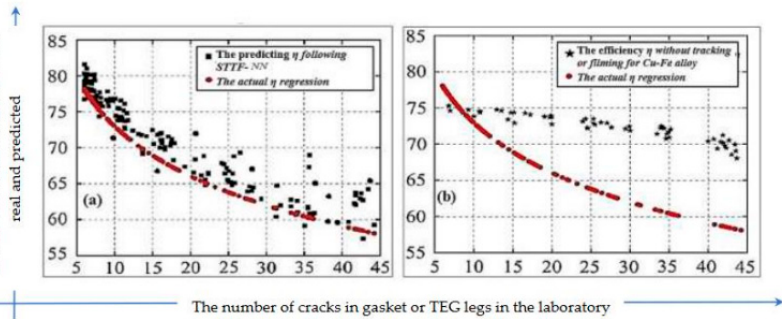
Figure 20. Comparison between the digital twin [STTF-NN] utilization results and the exact meas- urements for the behavior of cracks effects on generator efficiency η according to their P (cid:2919),(cid:2920) and Q (cid:2900) in two cases: ( a ) Al-Fe and/or Al-Cu alloys; ( b ) rejected Cu-Fe alloy.